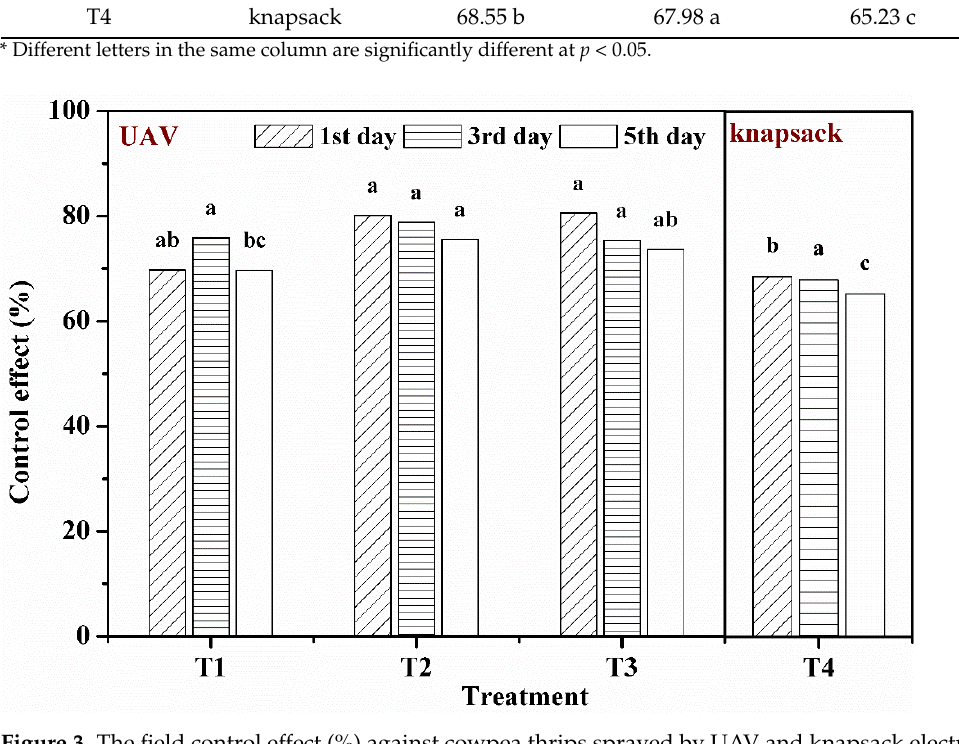
Figure 3. The field control effect (%) against cowpea thrips sprayed by UAV and knapsack electric sprayers. Different letters above the columns are significantly different at p < 0.05.